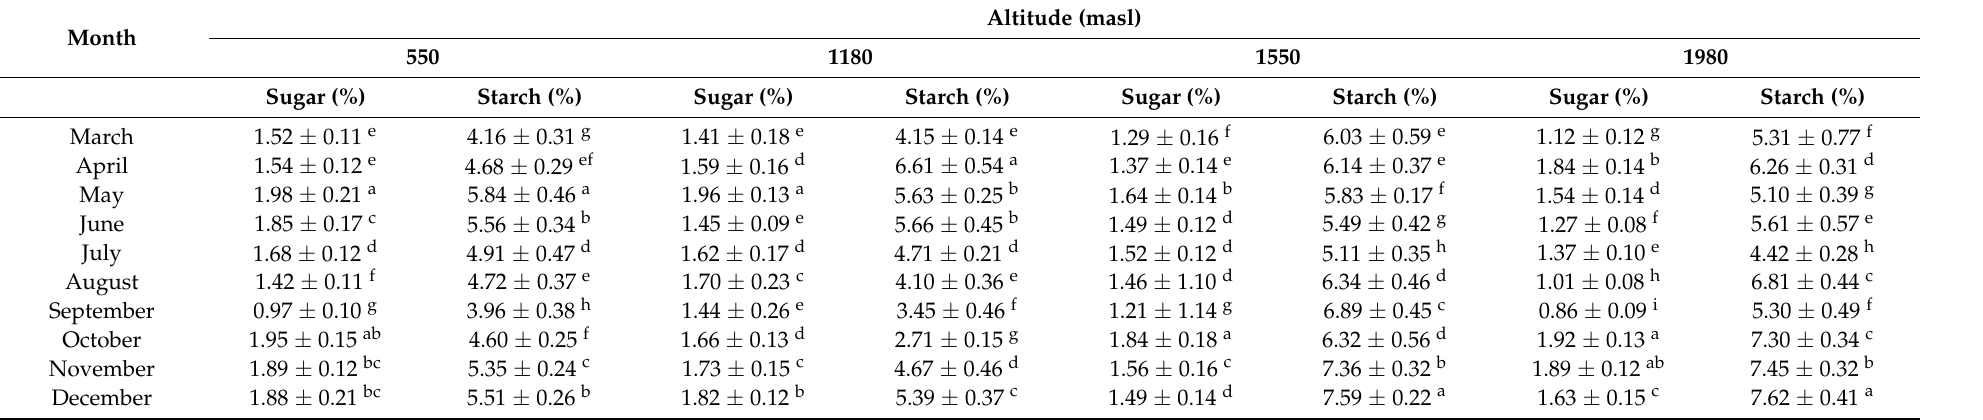
Table A3. Provenance and monthly variation in sugar and starch (%) in C. australis foliage ( ± SD). Means followed by the same letter are not significantly ( p < 0.05) different.